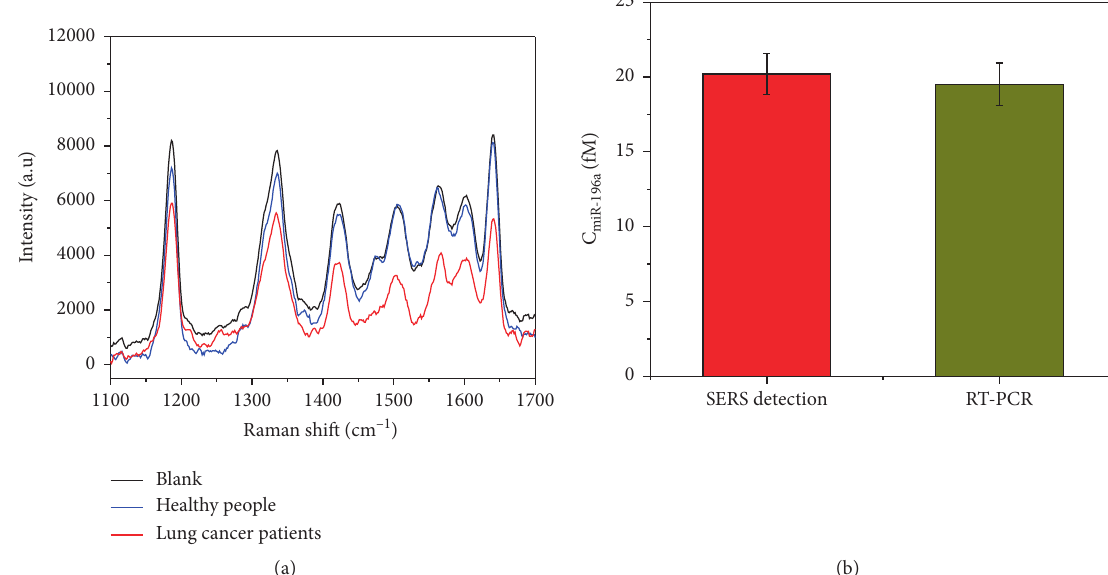
Figure 6: (a) SERS spectra of miR-196a expression in serum of lung cancer patients and healthy people. (b) The expression of miR-196a in serum of lung cancer patients detected by SERS platform and